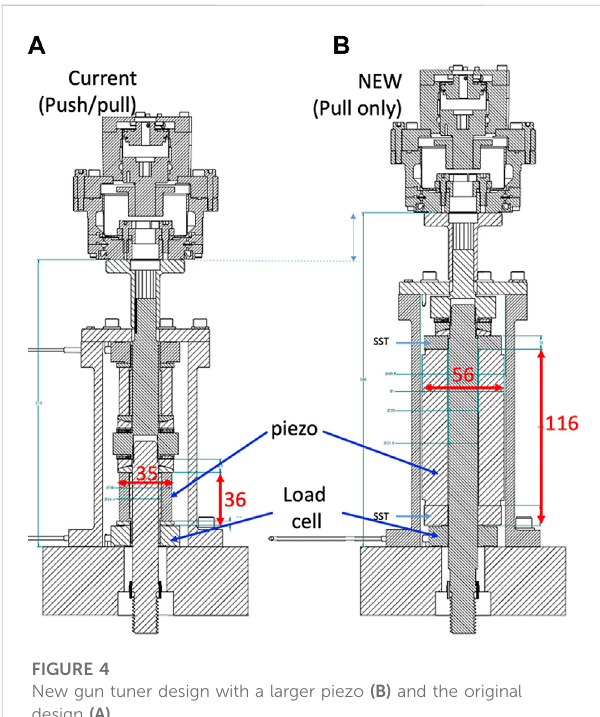
FIGURE 4 New gun tuner design with a larger piezo (B) and the original design (A)